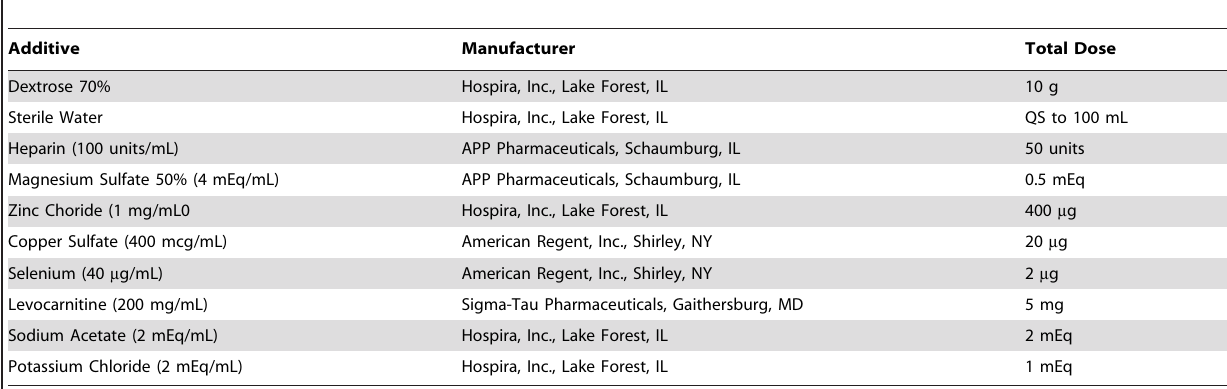
Table 1. Standard Parenteral Nutrition Additives for All Solutions Compounded in the Precipitation